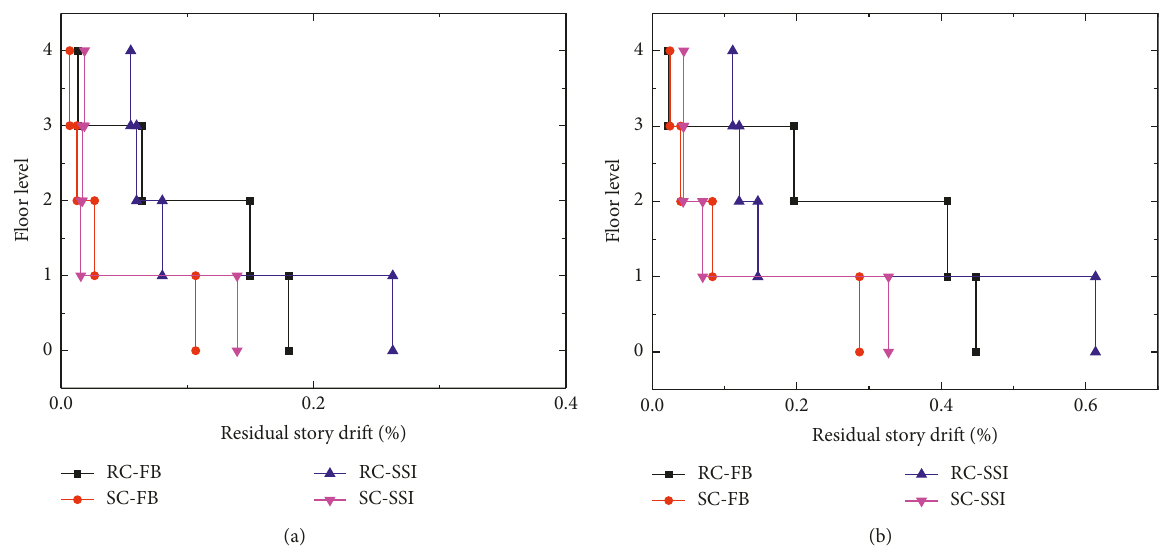
Figure 9: Residual story drift ratios of the RC and SC frames. (a) DBE. (b)